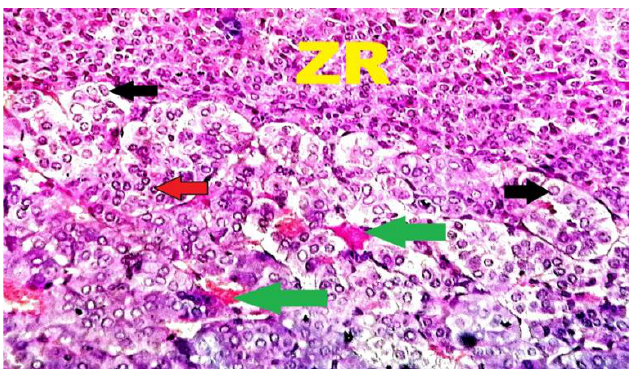
Figure 1. Squirrel histological section shows zonareticularis (ZR) and medulla. Chromaffin cells (black arrow) and sinusoid (green arrow). H&E , 40×